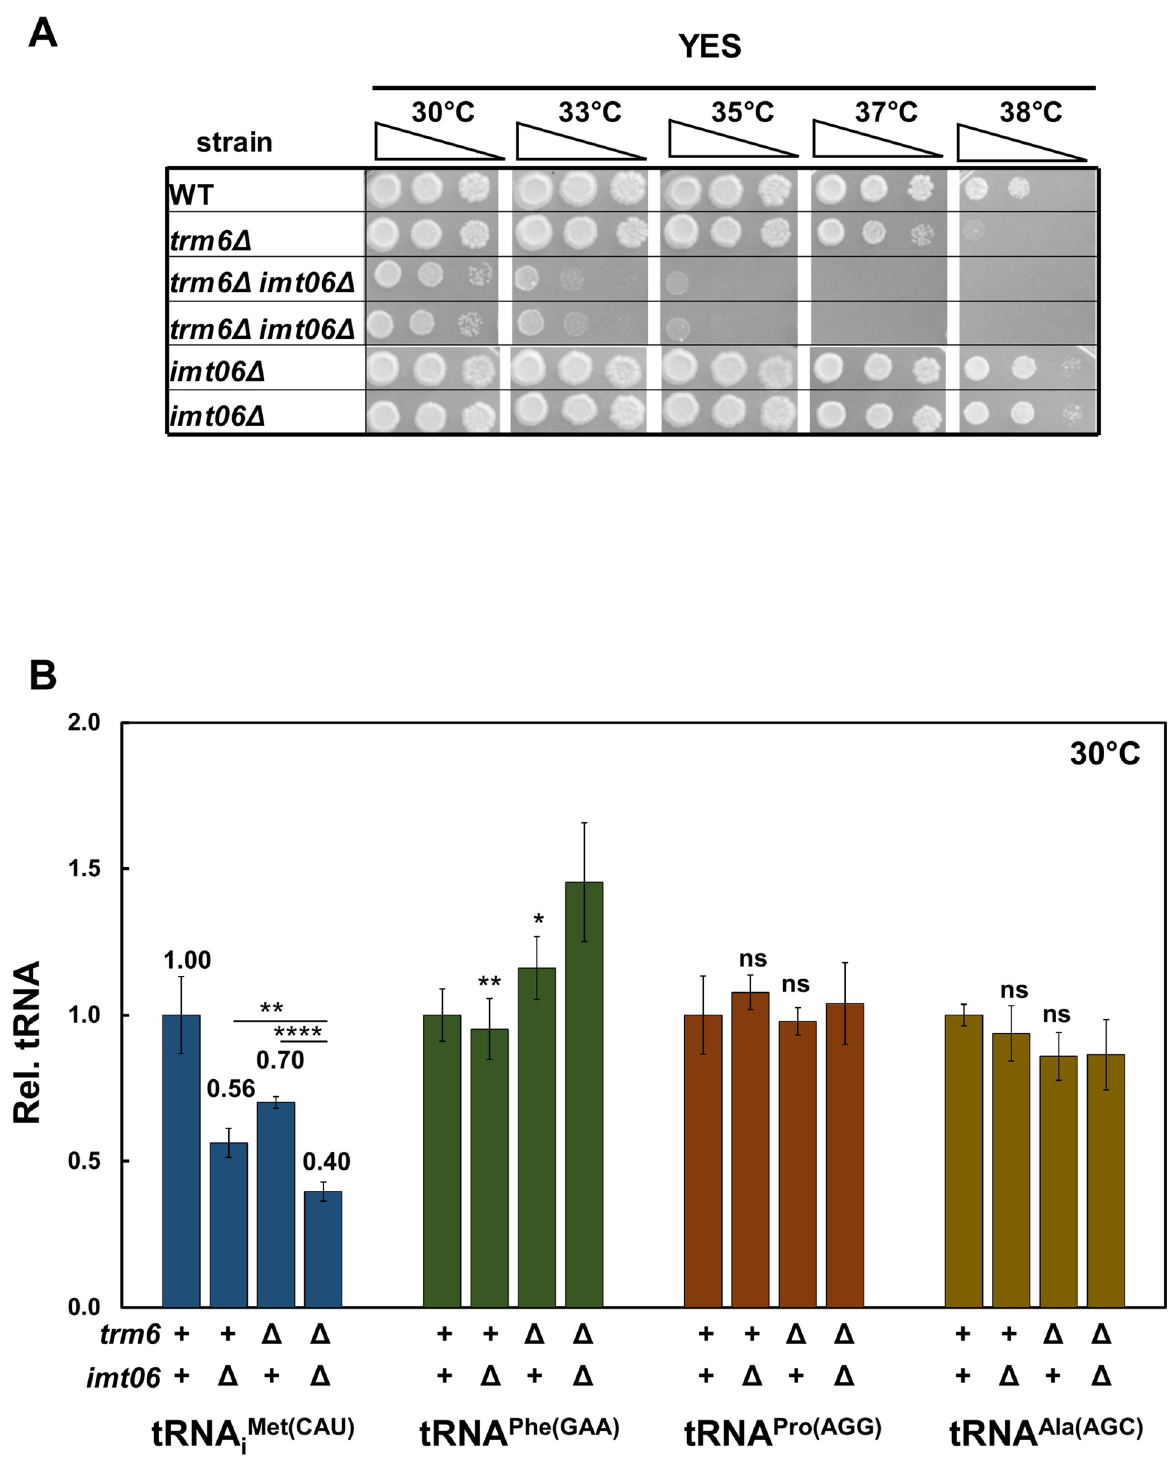
Fig 4. Deletion of one of the four S . pombe genes encoding tRNA i Met(CAU) in an S . pombe trm6 Δ mutant exacerbates its growth defect and further reduces tRNA iMet(CAU) levels. (A) Deletion of the imt06 + gene encoding tRNA iMet(CAU) in an S . pombe trm6 Δ mutant severely exacerbates its growth. Strains were grown overnight in YES media at 30˚C and analyzed for growth as in Fig 1A on indicated plates and temperatures for 4 days. (B) Quantification of tRNA iMet(CAU) levels in S . pombe trm6 Δ imt06 Δ mutants at 30˚C. tRNA levels were quantified as in Fig